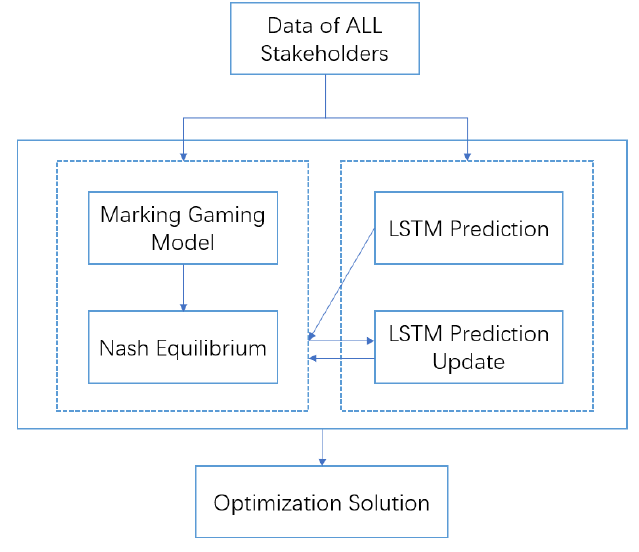
Figure 4. The overall framework of the optimization method.